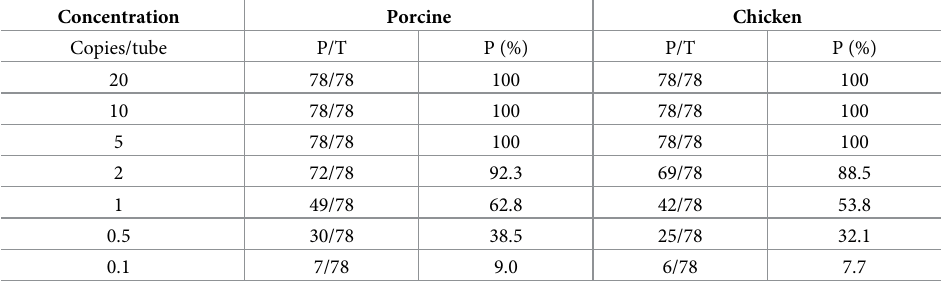
Table 5. Summary of collaborative trial results for the LOD 95% test. Concentration Porcine Chicken Copies/tube P/T P (%) P/T